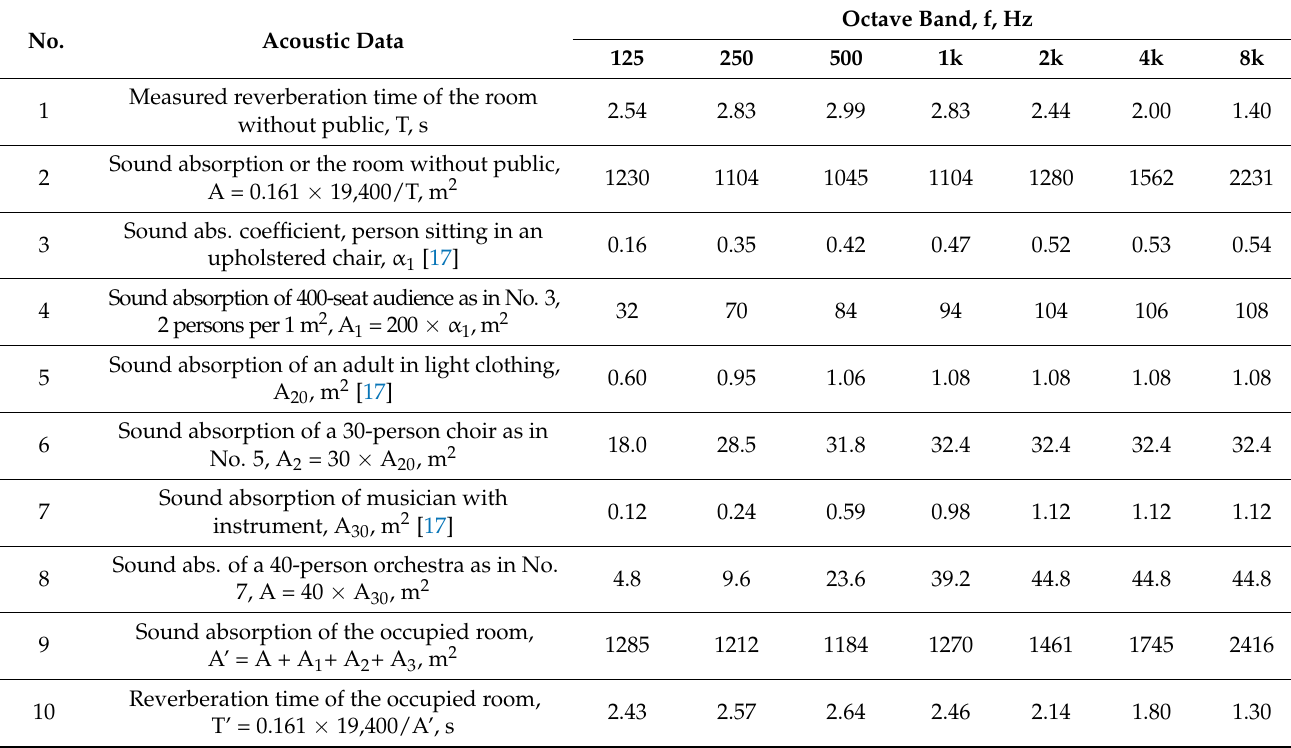
Table A1. Calculations taking into account the influence of the audience, choir and orchestra on the reverberation time during the stage performance of Ludvig van Beethoven’s opera Fidelio in the winter garden. No.